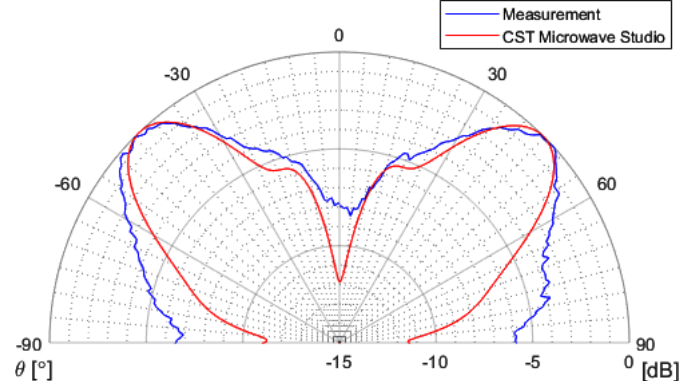
Figure 14. Simulated and measured response of a produced semi-cylindrical MTS, with a y -oriented short dipole as the source. Normalized to maximum